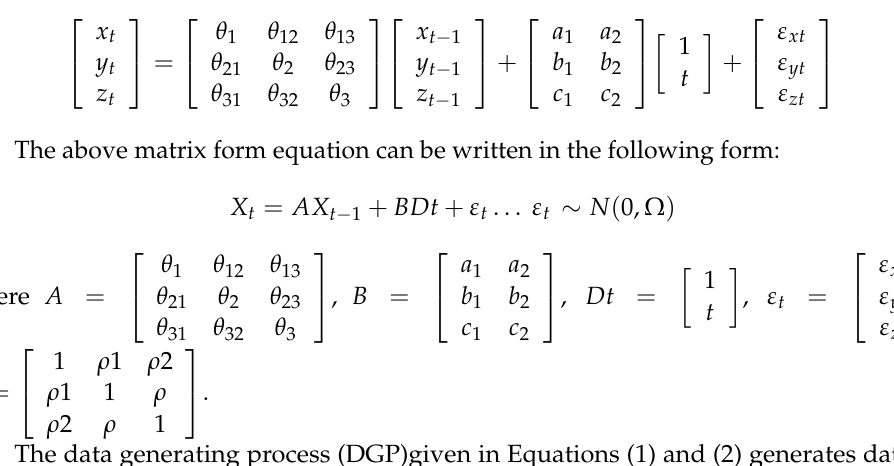
tions are significantly different from